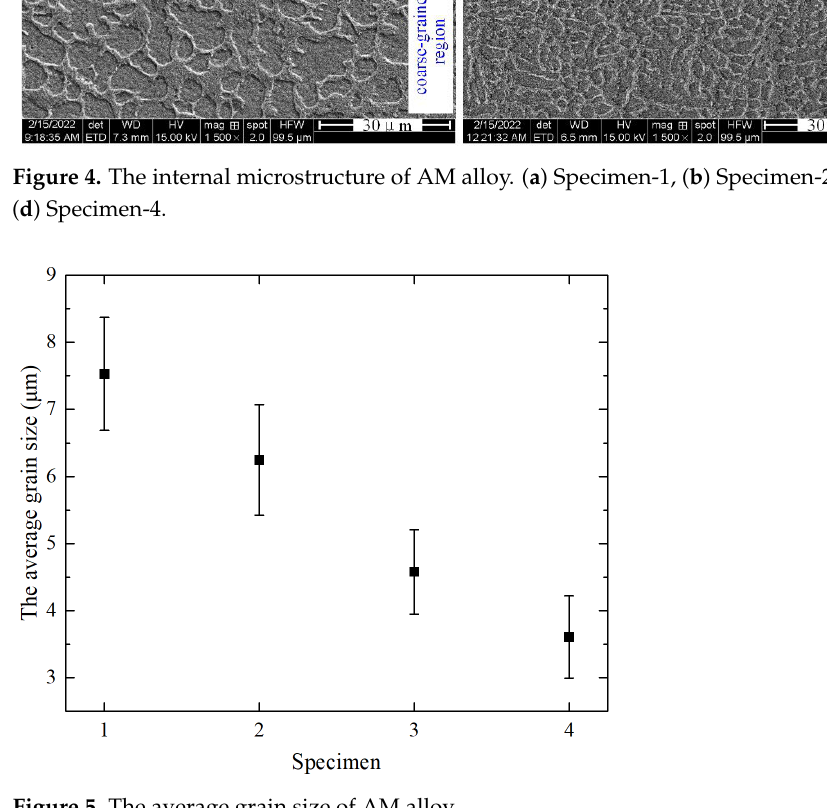
Figure 6. AM alloy line scan EDS curve (Specimen-4). In order to further analyze the element and phase distribution, quantitative analysis of the AM alloy energy spectrum was carried out using EDS point scanning. Figure 7a shows the element distribution of Specimen-1. As can be seen from the figure, compared with test points 3 and 4, the content of Cr element at points 1, 2 and 5 is significantly increased, and the mass fraction is higher than 18%, while the content of Fe element is reduced. The energy spectrum analysis of Specimen-2 can detect the weak La element, as